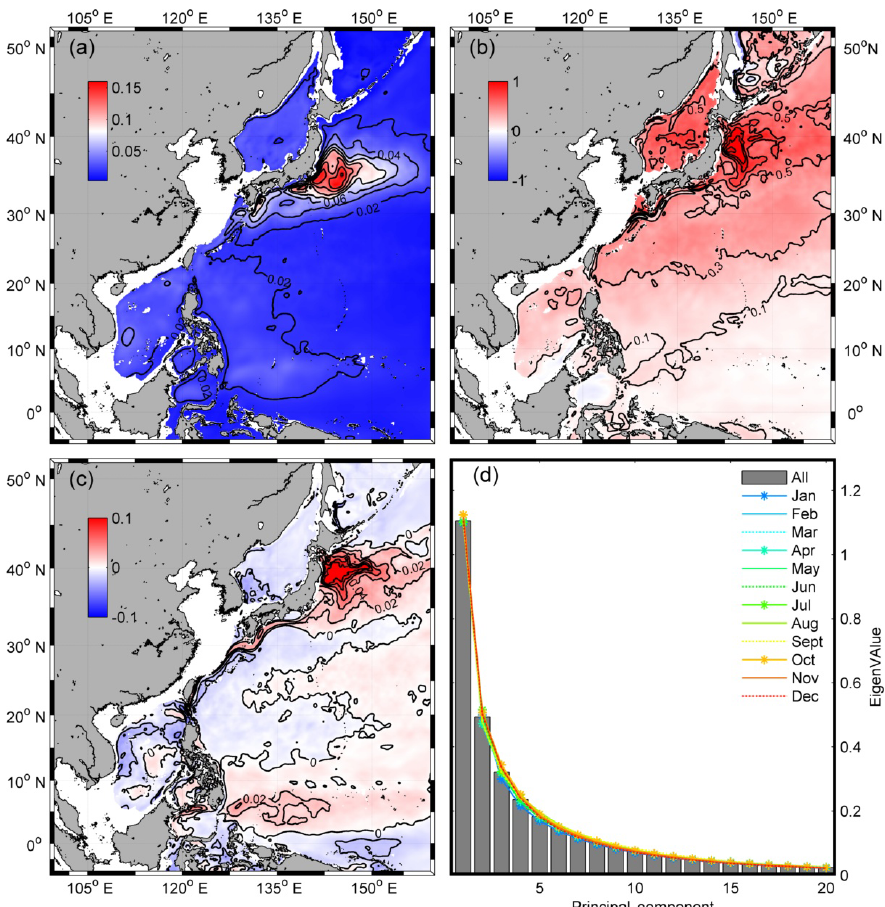
Figure 3. Distribution of yearly mean background-error standard deviation reconstructed from the EOFs: (a) sea level (m), (b) sea surface temperature ( ◦ C) and (c) sea surface salinity (psu). Areas shallower than 200m are masked out; (d) eigenvalues corresponding to the first 20